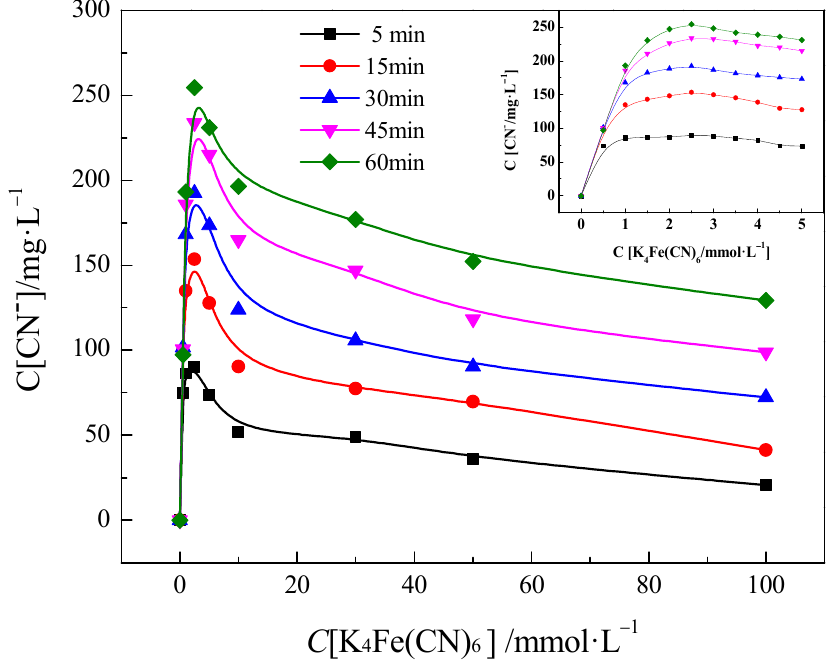
Figure 7. Number of free cyanide ions release in various concentrations of PF at time stages (0–60 min) under ultraviolet irradiance of 10 mW · cm − 2 high pressure mercury lamp (buffered at pH